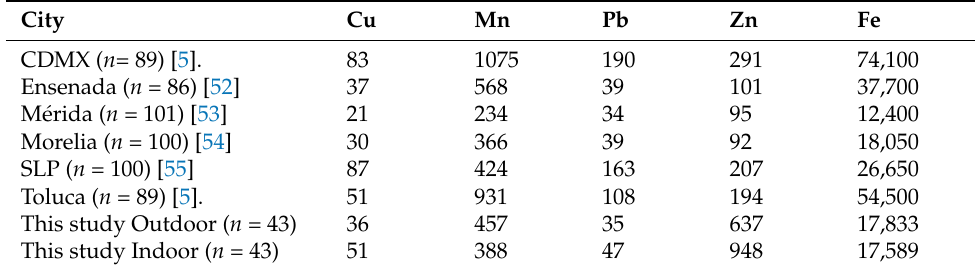
Table 5. Concentrations of heavy metals in urban dust in